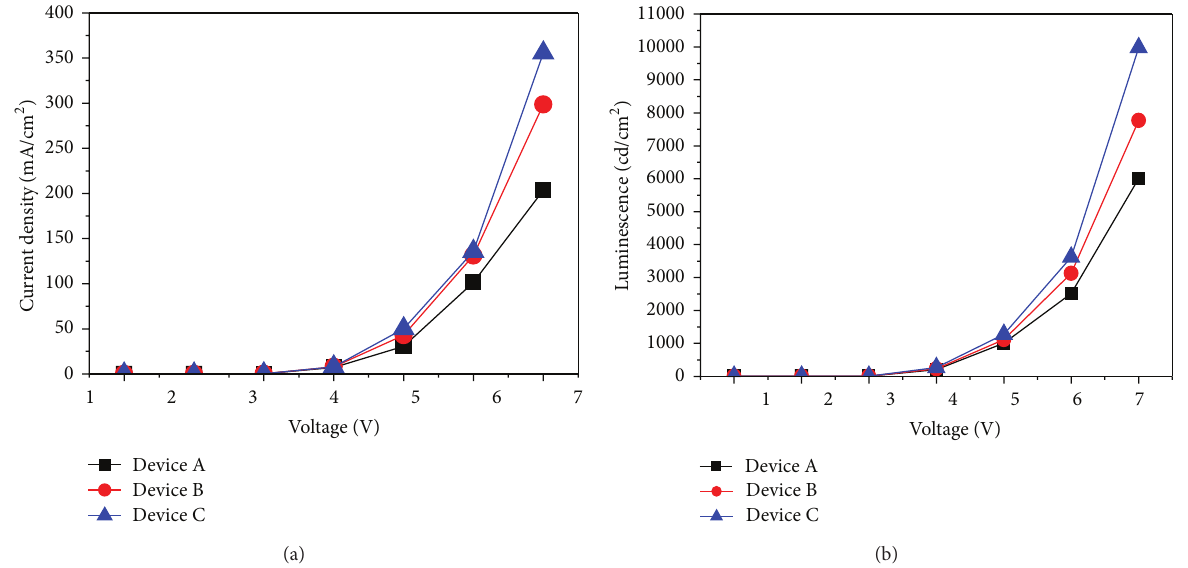
Figure 6: (a) The current density versus bias voltage (J-V) characteristics of devices A ∼ C. (b) The luminance versus voltage (L-V) character- istics of devices A ∼ C.